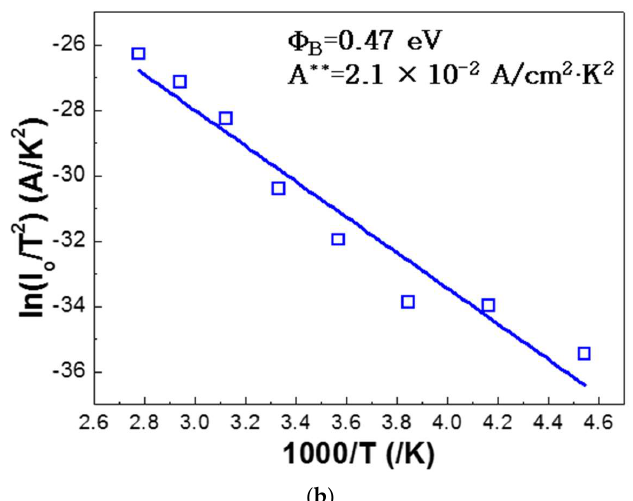
Figure 3. ( a ) Barrier height and ideality factor versus temperature in Au/HVPE a-plane GaN templates formed by in situ nanodot formation; ( b ) Richardson plot of ln( I 0 / T 2 ) versus 1000/ T for Au/HVPE a-plane GaN Schottky contact.